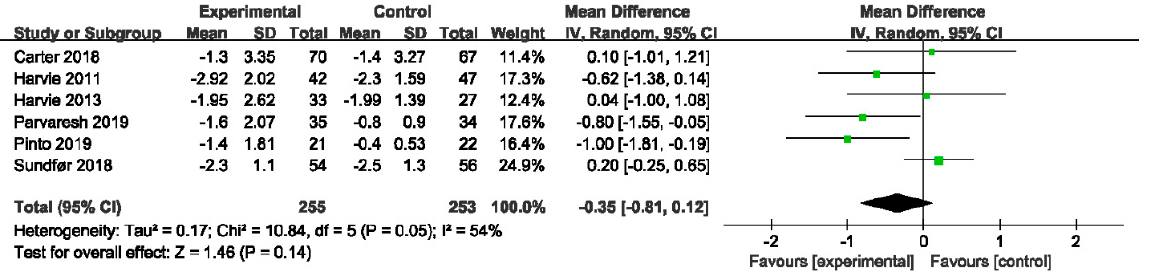
Figure 4. Forest plot for BMI in trials that compared IER with CER. Abbreviations: CI, confidence interval; BMI, body mass index; IER, intermittent energy restriction; CER, continuous energy restriction. The unit of mean difference in BMI is kg/m 2 .